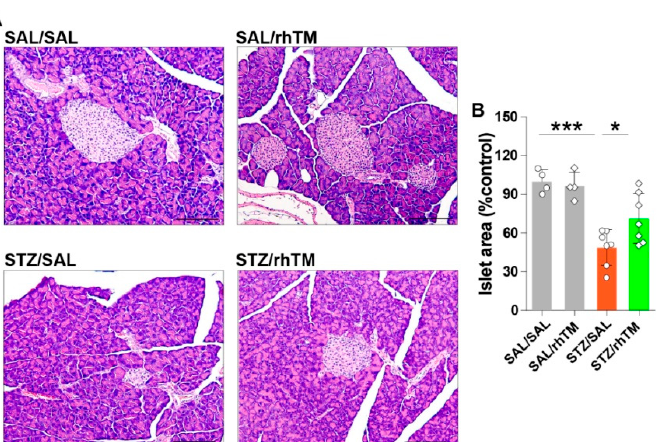
Figure 2. Treatment of diabetic mice with recombinant human thrombomodulin increased the area of pancreatic islets. ( A ) Hematoxylin & eosin staining of the pancreas in each group. ( B ) Area of pancreatic islets measured in each group using the WinROOF image processing software. Scale bars indicate 200 µm. Data are the mean ± S.D. Statistical analysis by ANOVA and Tukey’s test. * p < 0.05, *** p < 0.001. SAL/SAL, mice received intraperitoneal injection of SAL and were treated with SAL. SAL/rhTM, mice received intraperitoneal injection of SAL and were treated with rhTM. STZ/SAL, mice received intraperitoneal injection of STZ and were treated with SAL. STZ/rhTM, mice received intraperitoneal injection of streptozotocin (STZ) and were treated with recombinant human thrombomodulin (rhTM).